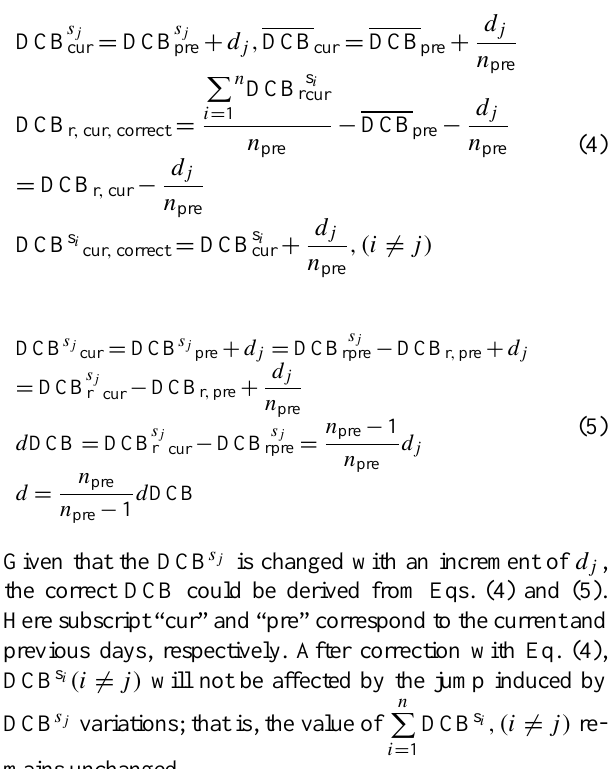
remove the jumps in the DCB series induced by the zero- mean condition. Moreover, the zero-mean condition will also be changed under the situation that not all satellites are avail- able for the GNSS network. The effect of the zero-mean con- dition is equivalent to a hardware change that changes the DCB of unavailable satellites to zero in corresponding